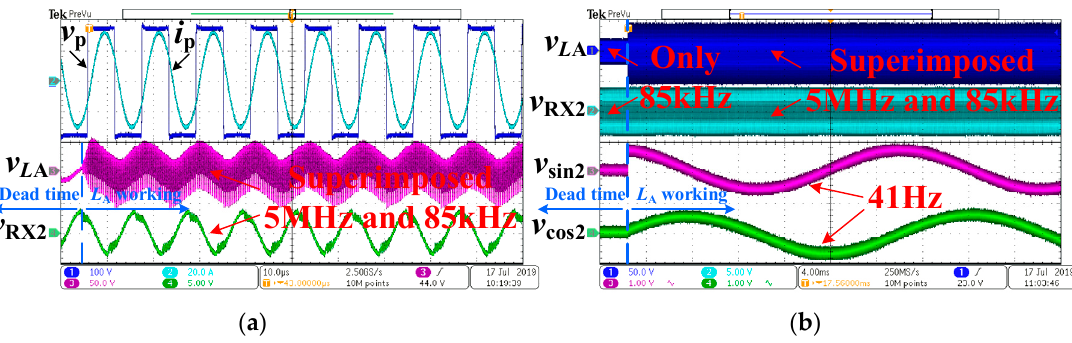
Figure 17. Online positioning under 3.3 kW power transfer: ( a ) transmitting waveform v L A and receiving waveform v RX2 ; ( b ) amplitude measurement waveforms v sin2 and v cos2 .